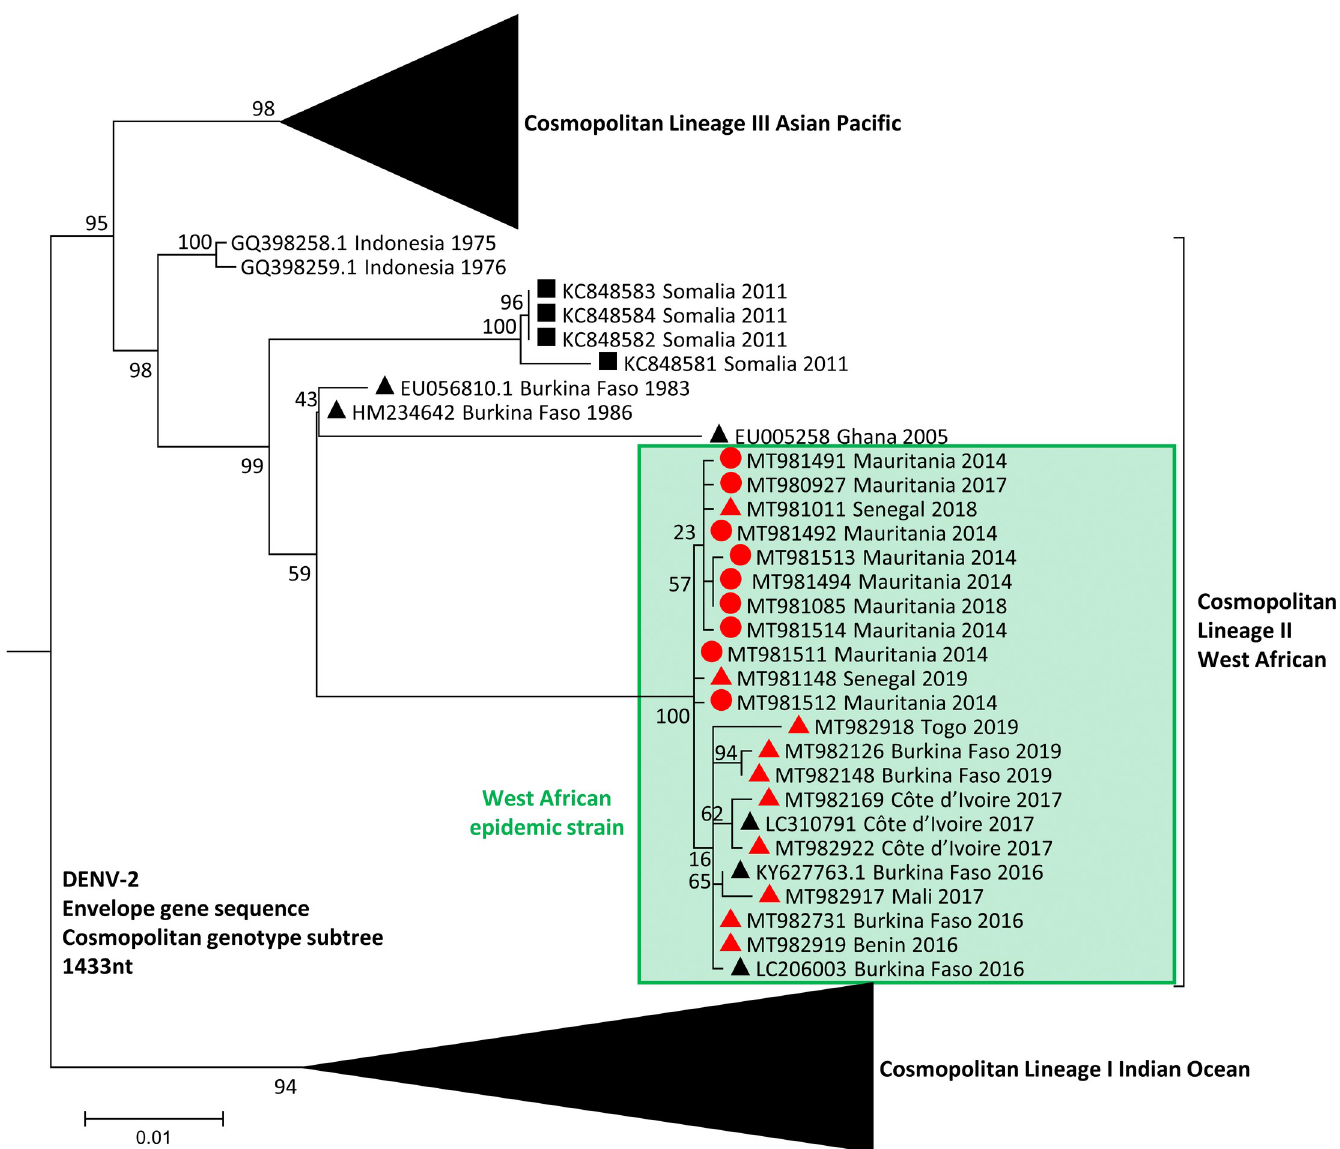
Fig 2. Maximum-likelihood phylogenetic tree based on envelope gene sequence of DENV-2 strains. DENV-2 strains from our data set are indicated by red circles for Mauritanian strains and red triangles for strains from other West African countries. Sequences retrieved from GenBank are indicated by black triangles for West Africa and black squares for the rest of Africa. The tree was constructed using 382 envelope gene sequences. DENV, dengue virus.